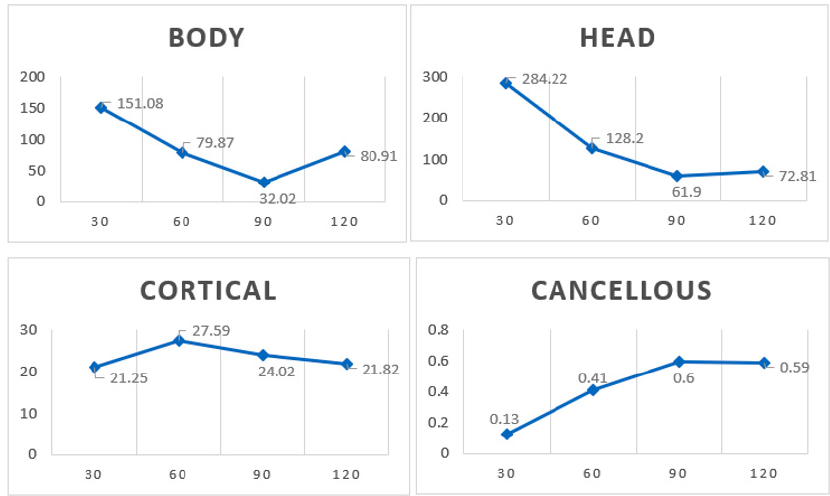
Figure 3. Mean von Mises stress level variation with the different insertion angles.